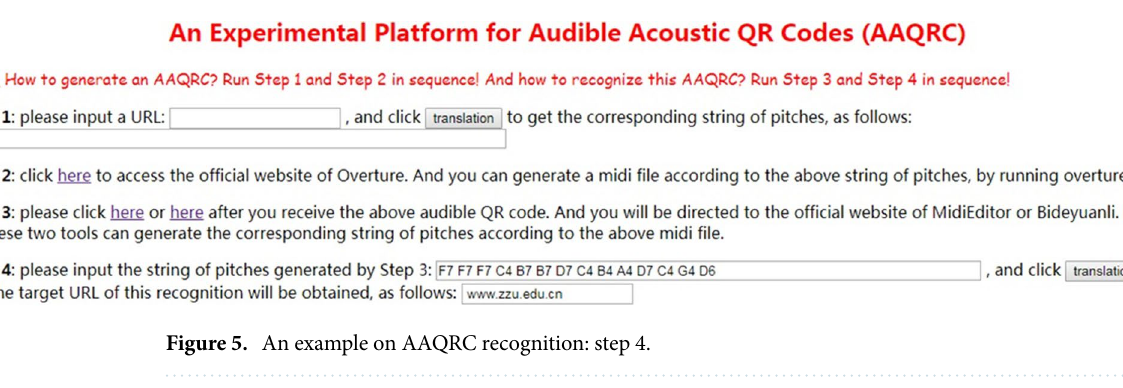
Figure 5. An example on AAQRC recognition: step